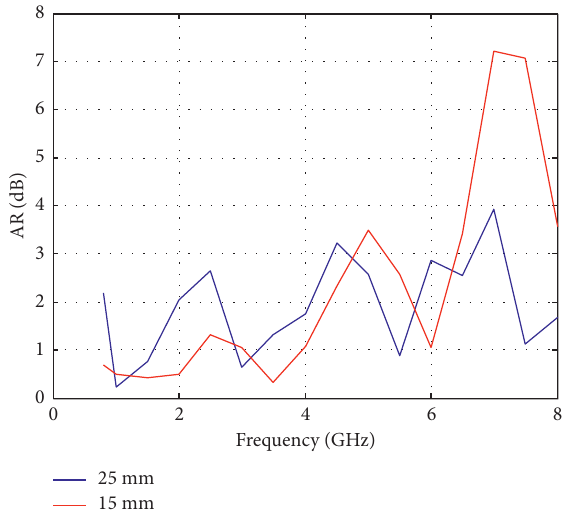
Figure 14: Simulated AR of antennas with different disc ground radii.